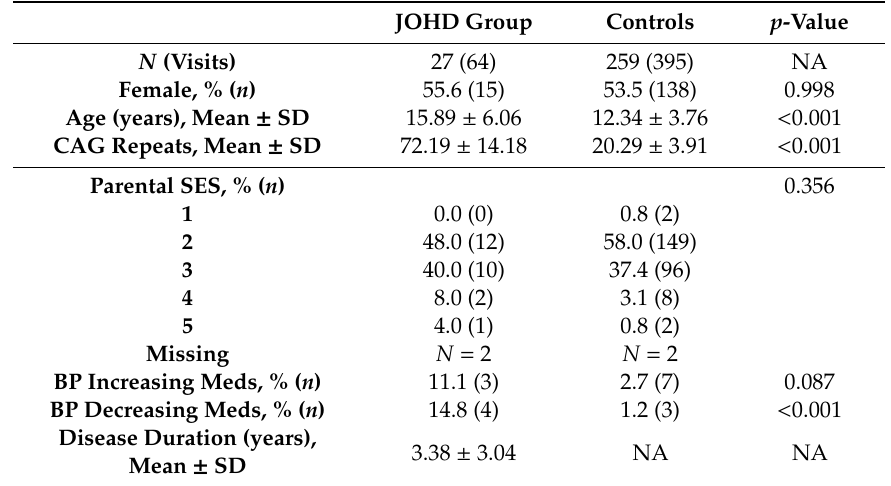
Table 1. Baseline demographics by groups.